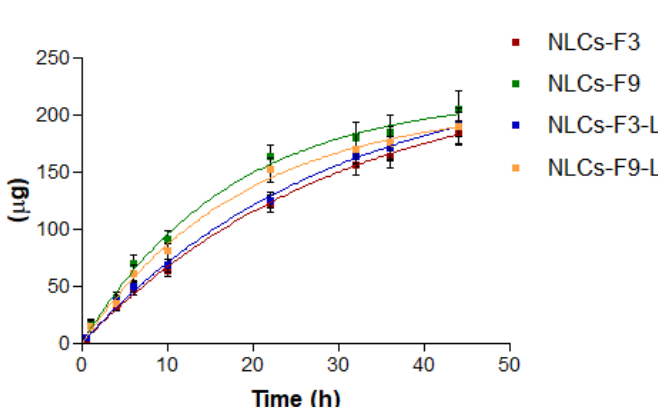
Figure 6. In vitro Pranoprofen (PF) release profiles from the optimized nanostructured lipid carriers. The cumulative amount was plotted versus time. Data are represented as mean ± SD ( n = 3).